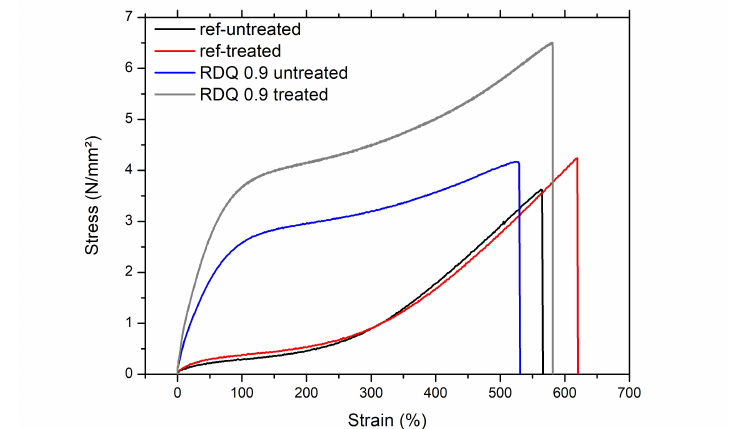
Figure 4. Comparison between untreated and treated nanocomposites with high relative dispersion quality vs. untreated and treated reference material.